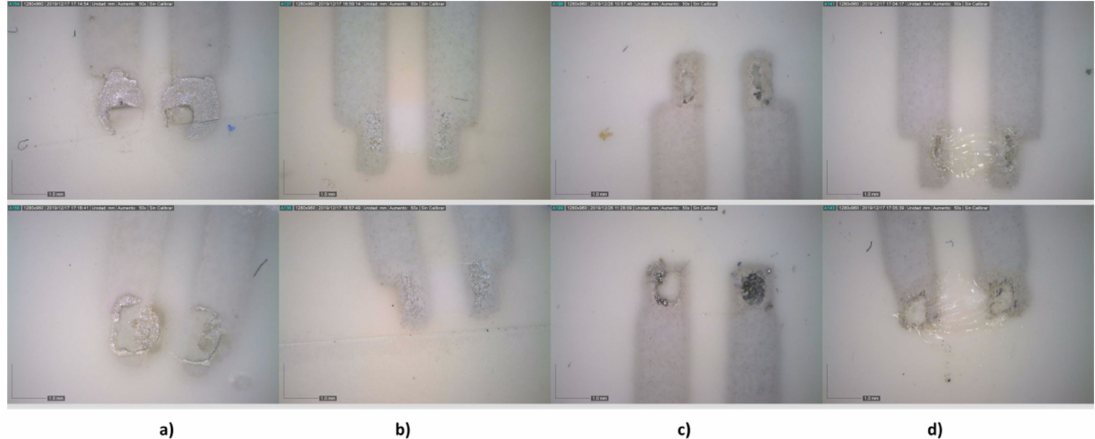
Figure 17. Effect of shear force on the solder reflow footprint: X axis (above) and X axis (rotation) (below). ( a ) Inkron IPC-603X, ( b ) DELO MONOPOX AC245, ( c ) NC-SMQ80/1E, and ( d ) Voltera T4/T5.